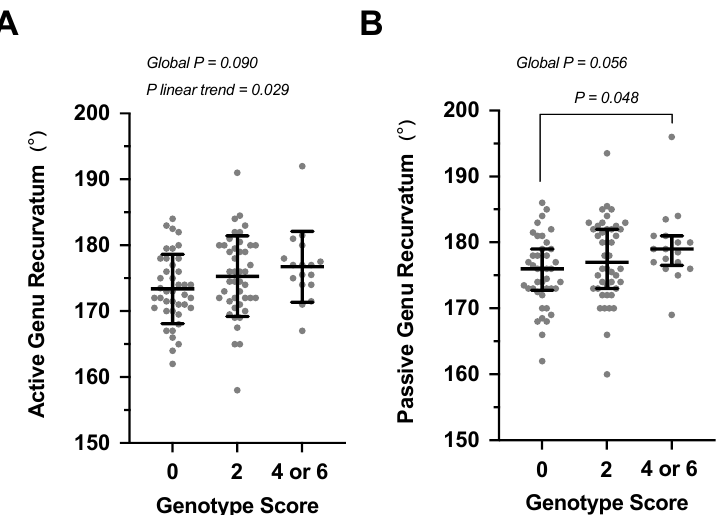
Figure 1. The ( A ) mean ± standard deviation of the active and ( B ) median (IQRs) of the passive genu recurvatum of the α 1(V) ( COL5A1 ), α 1(XI) ( COL11A1 ) and α 2(XI) ( COLL12A1 ) collagen genotype scores. Participants received a genotype score of 2 for each COL5A1 rs12722 CC, COL11A1 rs3753841 CC, COL11A1 rs1676486 TT and COL12A1 rs1799907 AA genotypes and 0 for all other genotypes, so that the genotype scores ranged from 0 to 8. None of the participants had a genotype score of 8 and the genotype scores of 4 and 6 were combined for the analysis. The individual values are shown as solid grey circles. The global test for linear trend and the Dunn’s multiple comparisons test p values are indicated. Lower degree values for genu recurvatum indicates a greater amount of knee hyperextension.